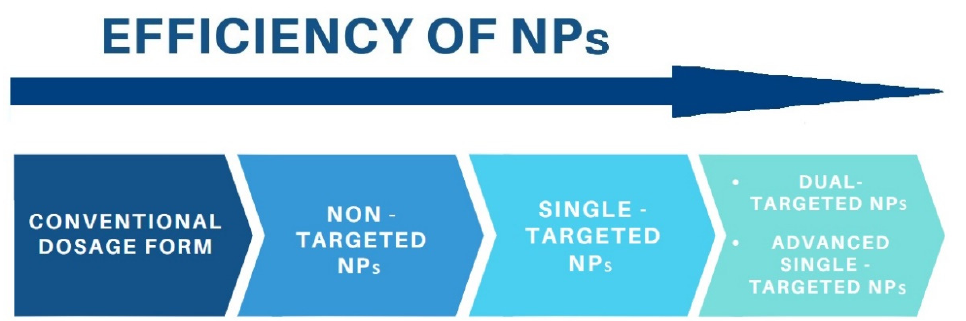
Figure 9. Evolution of nanoparticulate delivery system of anticancer drugs toward improvement of efficiency and decrease of toxicity.